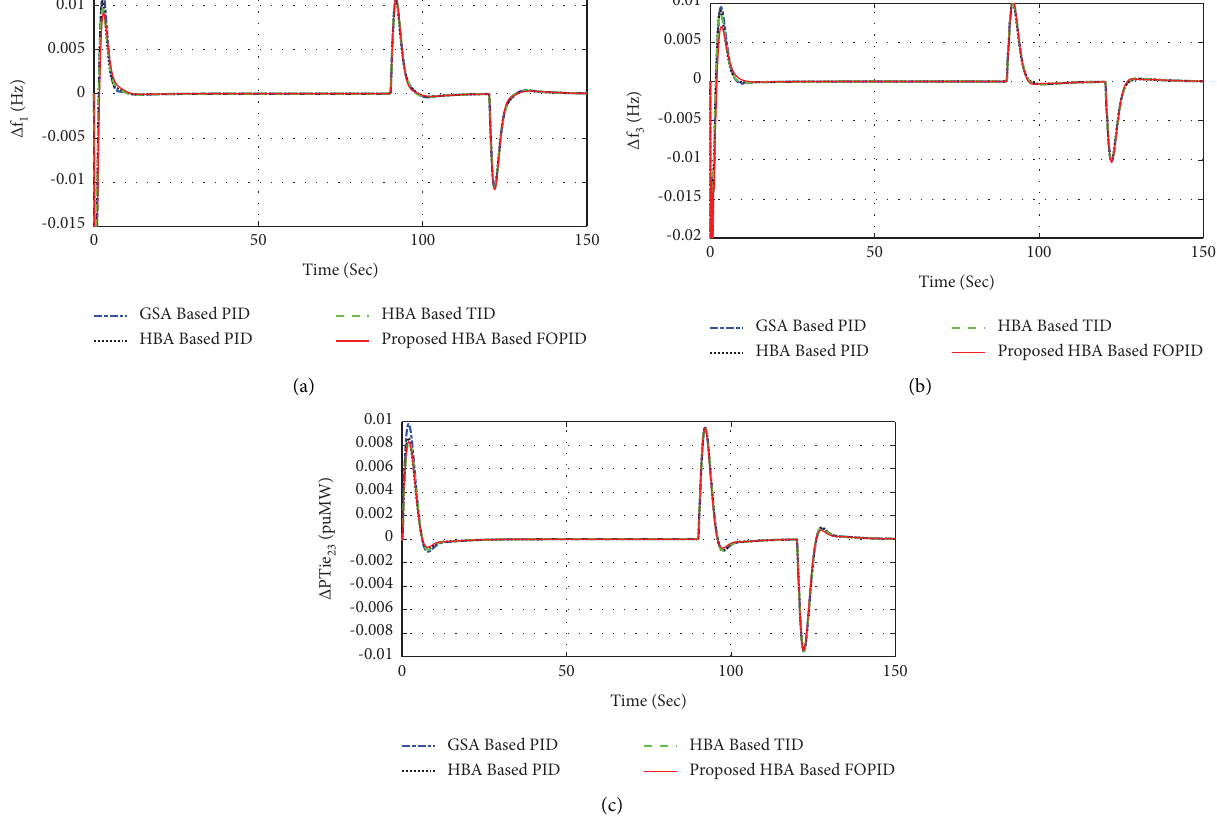
1 , (b) A 3 , and (c) P tie23 .